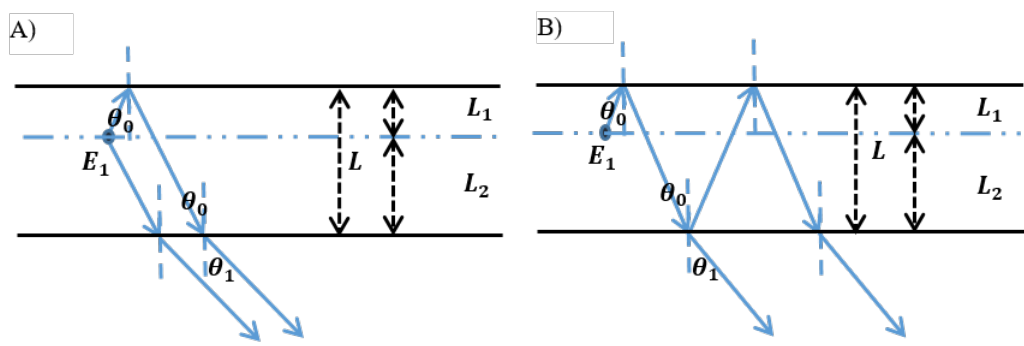
Figure 1. ( A ) Wide-angle interference and ( B ) multi-beam interference in micro-cavity bottom-emitting OLEDs. E 1 represents the emission in the EML; θ 0 and θ 1 are incident angle and refraction angle on electrodes, respectively; L 1 , L 2 , L are the optical path from EML to two electrodes and between two electrodes, respectively.